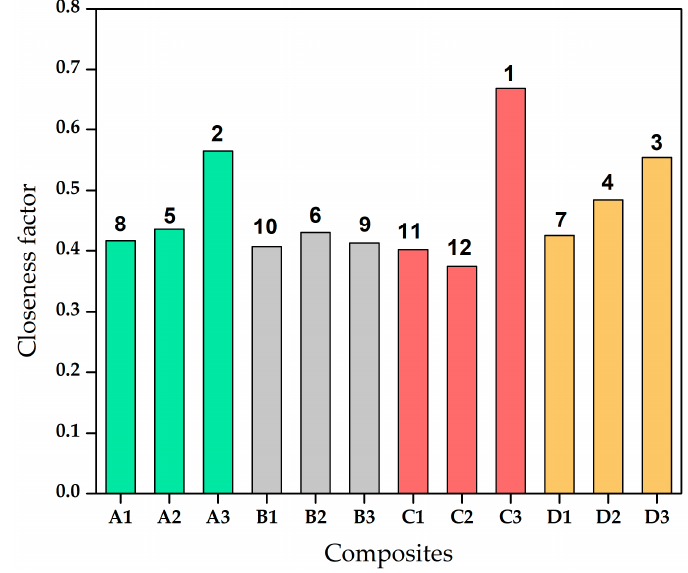
Figure 8. Ranking of composites based on physical, wear, and mechanical behaviour.